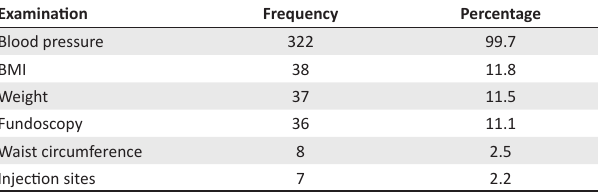
TABLE 2: Documented routine examinations in reviewed files ( N =